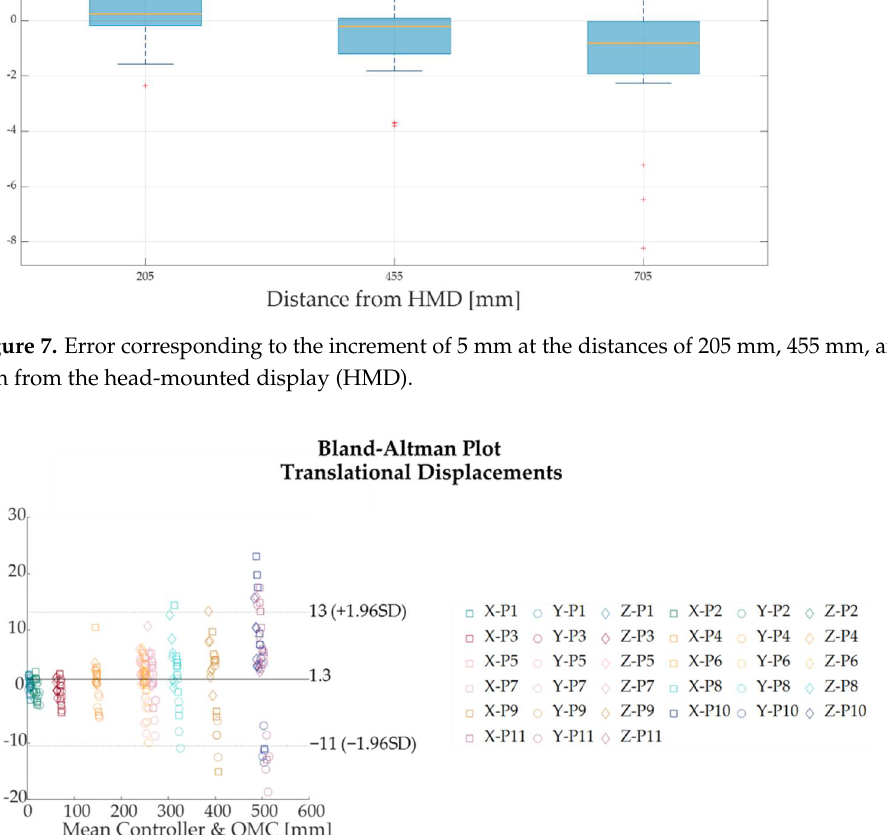
Figure 8. Bland–Altman plots comparing the translational displacements measured by the Qualisys Optical Motion Capture (OMC) system and by the Controller A of the Oculus Quest 2.